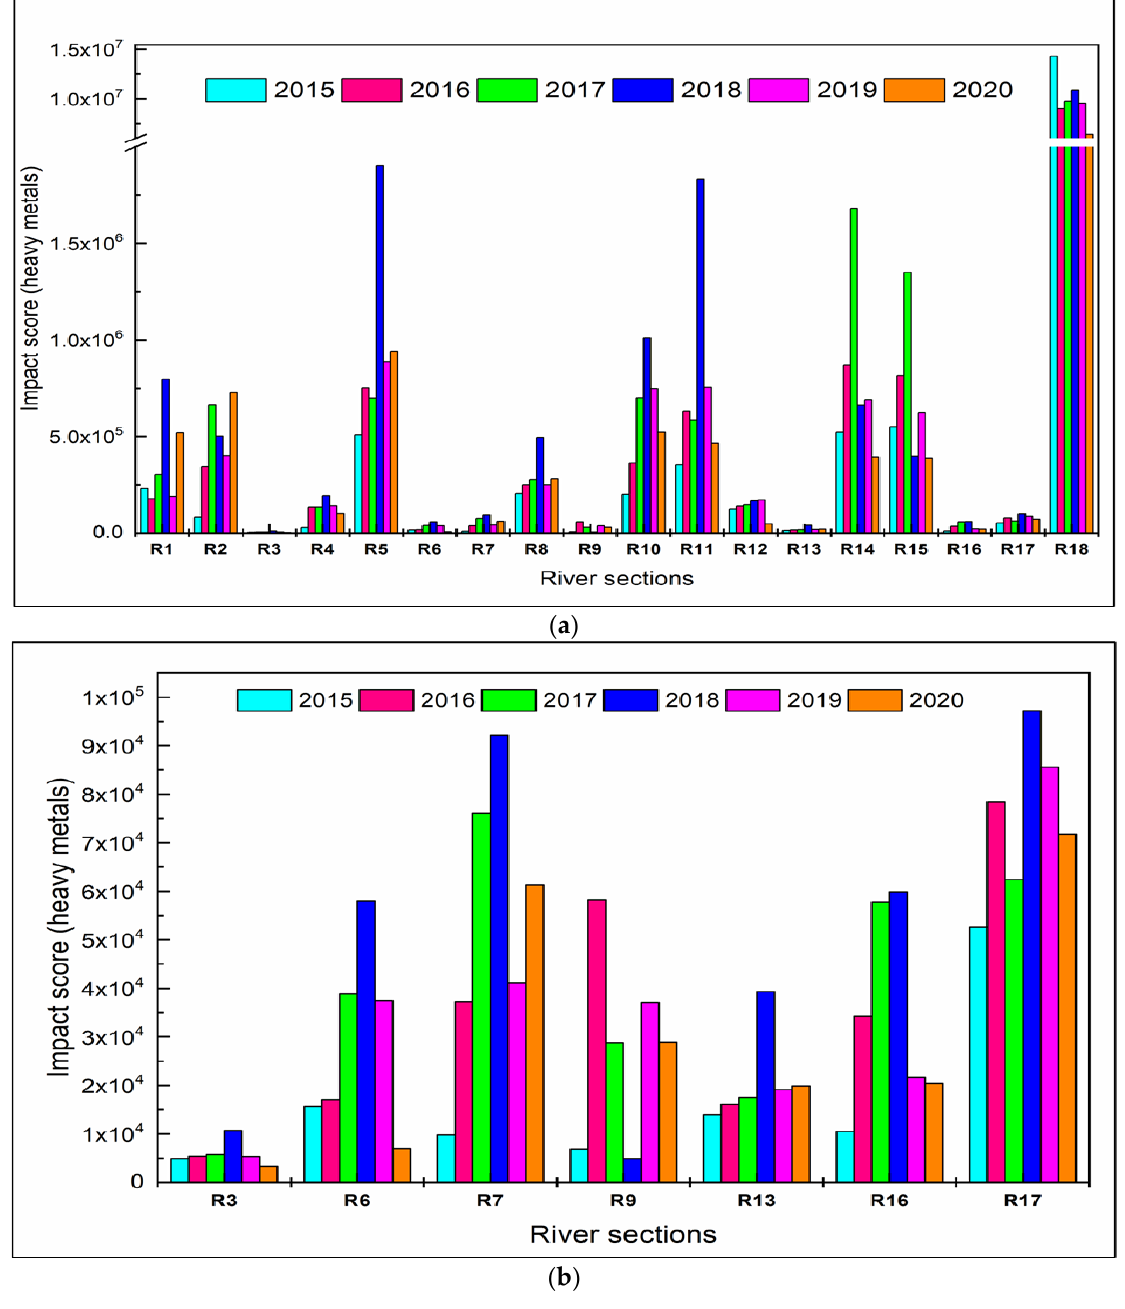
Figure 2. Carcinogenic impact score for heavy metals: ( a ) R1 - R18 sections on the original scale; ( b ) a deeper view of selected sections (R3, R6, R7, R9, R13, R16, R17).